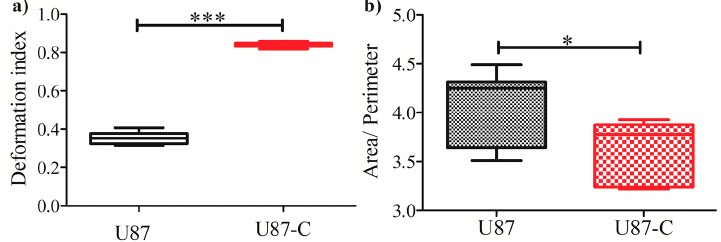
Figure 6. Comparisons of deformation indexes and area/perimeter. ( a ) Deformation indexes differences between U87 and U87-C. Student’s two-tailed t -test was applied, p < 0.0001. ( b ) Differences of the area to perimeter ratio according to the Student’s two-tailed t-test, p -value is 0.0258. * and *** implies for p < 0.05 and p < 0.0001, respectively.